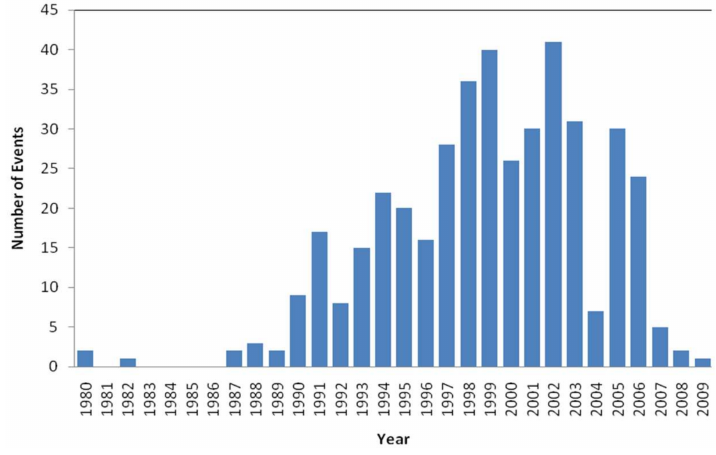
Figure 2. Histogram of the annual frequency.